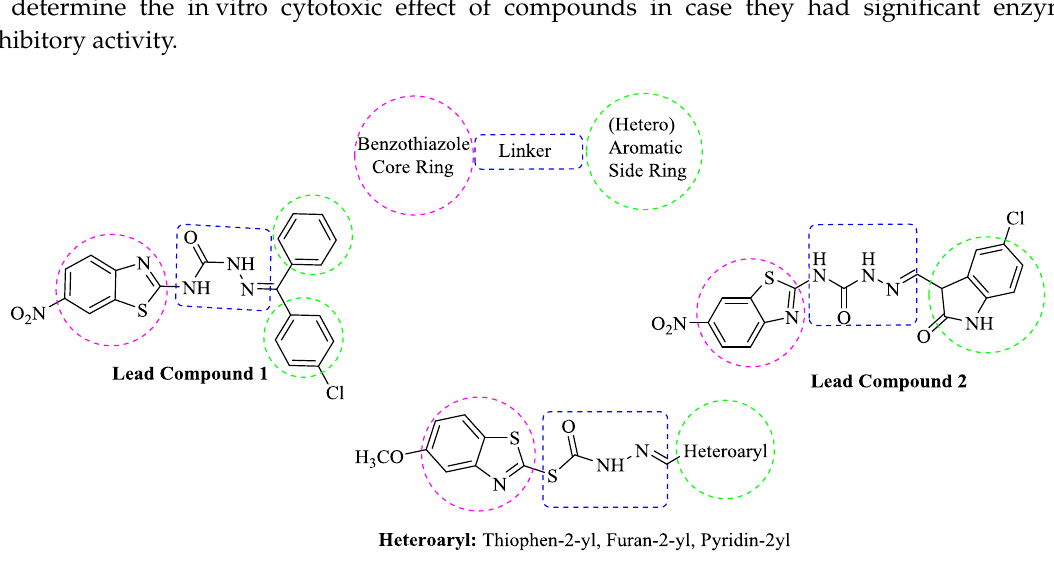
Figure 1. Examples of structures displaying MAO-B inhibitory activity and the designed compounds ( 3a–3j